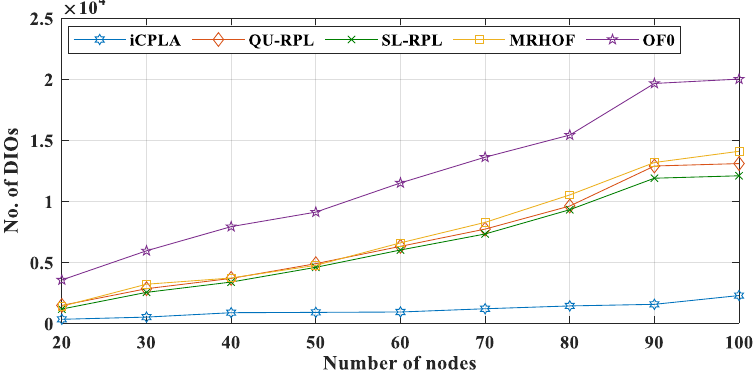
Figure 9. Comparison of number of DIO control messages between i CPLA, QU-RPL, SL-RPL, MRHOF, and OF0 with 𝛼 = 0.3 and 𝛽 = 0.7 in a network of 20 to 100 nodes.